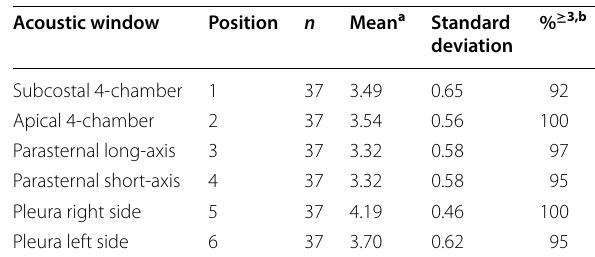
image scores by acoustic window of telementored ultrasound in six different cardio-thoracic windows (FATE)